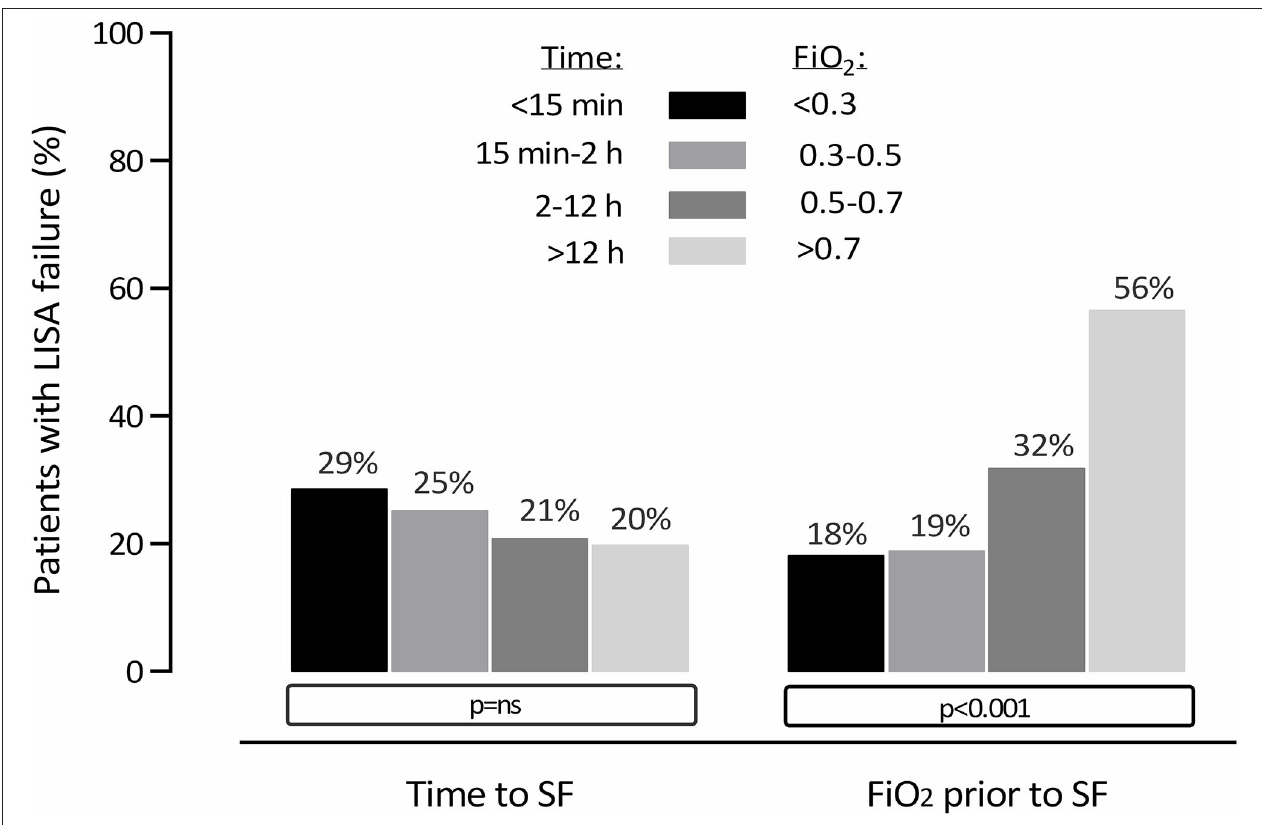
FIGURE 2 | Need for MV < 72h of life indicating LISA failure, stratified by time to SF and FiO 2 prior to SF.